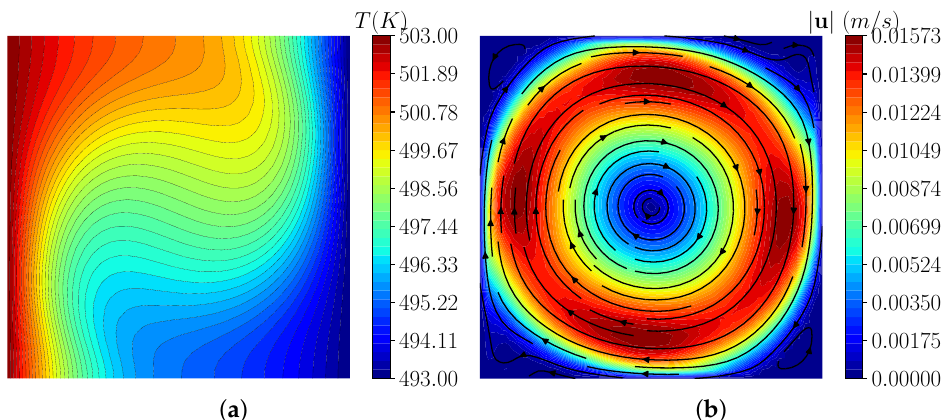
Figure 2. Uncontrolled solution: contours of the temperature field T ( a ); contours and streamlines of the velocity field u ( b ). The velocity magnitude is indicated by